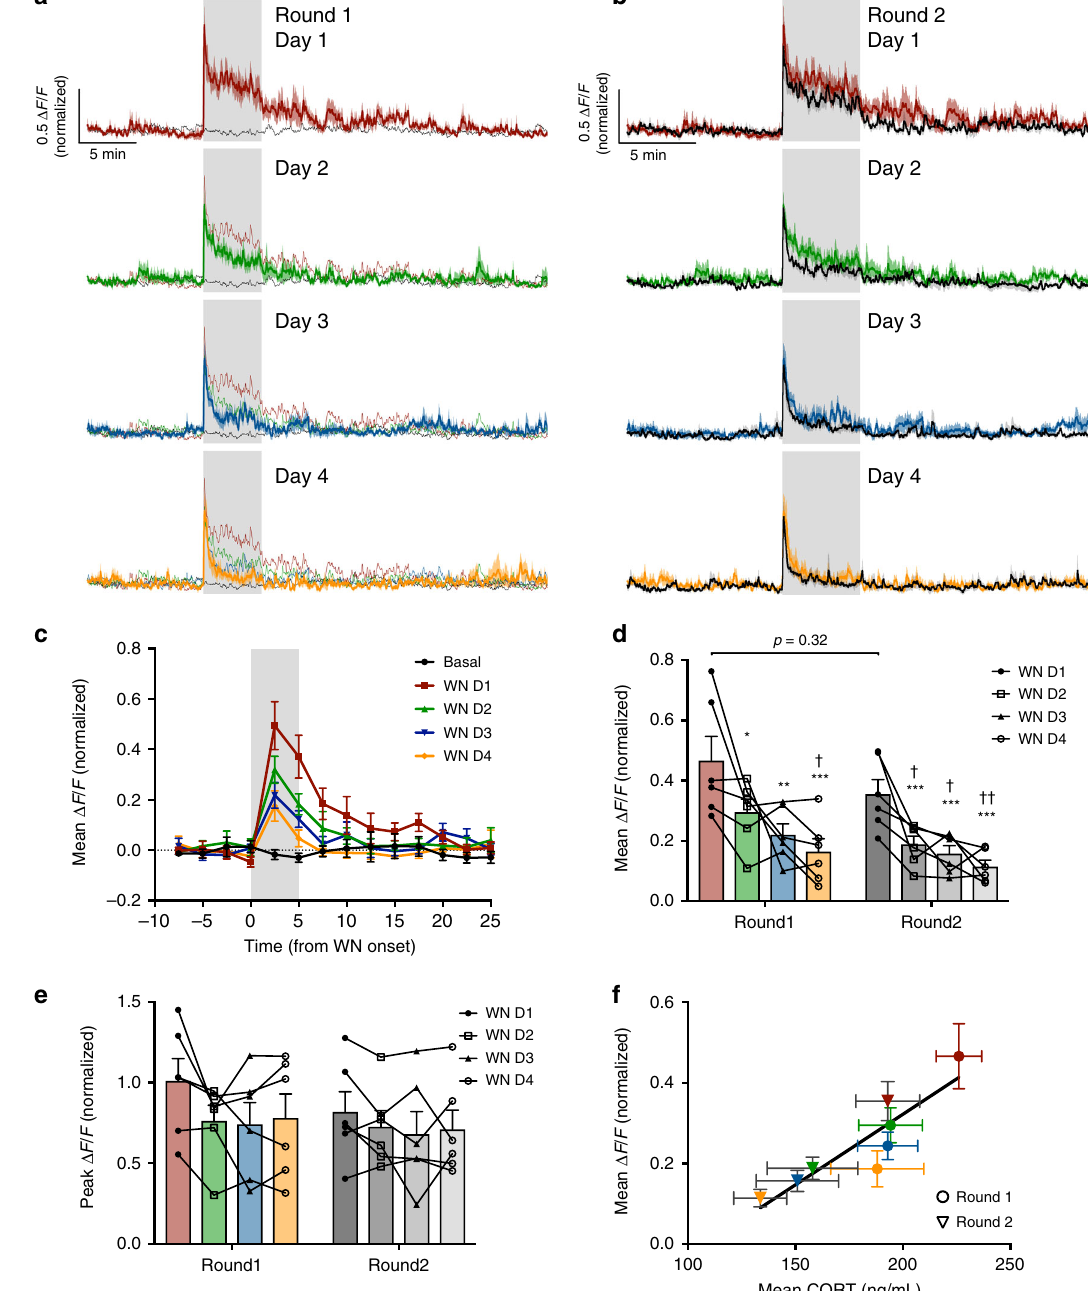
Fig. 8 Long-term adaptation of CRH neural activity to stress. a Mean photometry signals of CRH neuron activity from mice receiving daily WN stress over 4 days (round 1: day 1; red; day 2, green; day 3, blue; day 4, orange). Black trace indicates mean CRH neuron activity from the same cohort of mice on day 0, in the absence of WN. b Mean photometry signals of CRH neuron activity from the same mice after a 3-week rest interval (with no stress) and then subsequently receiving daily WN stress over 4 more days (round 2: all recordings in black overlaid with corresponding round 1 WN response). c Mean Δ F / F changes in response to each WN or no stress (black) in 2.5 min bins during round 1. d Average Δ F / F of CRH neuron activity during WN stress across the two rounds of repeated stress; n = 6, RM two-way ANOVA, * p < 0.05 vs. round 1 WN day 1, † p < 0.05 vs. round 2 WN day 1, Holm – Sidak; ANOVA interaction p = 0.77, ANOVA main effect of group p = 0.09. e Peak Δ F / F at WN onset across the two rounds of repeated stress; RM two-way ANOVA, Holm-Sidak; ANOVA interaction p = 0.53, ANOVA main effect of group p = 0.60. f Correlation of mean CRH neuron activity during WN and corresponding post-stress blood CORT concentration across the two rounds (round 1 in circles and round 2 in triangles, 4 days of WN indicated by corresponding color; Pearson ’ s r = 0.90, r 2 = 0.8. All data presented as mean ± SEM, */ † p < 0.05, **/ †† p < 0.01, ***/ ††† p <